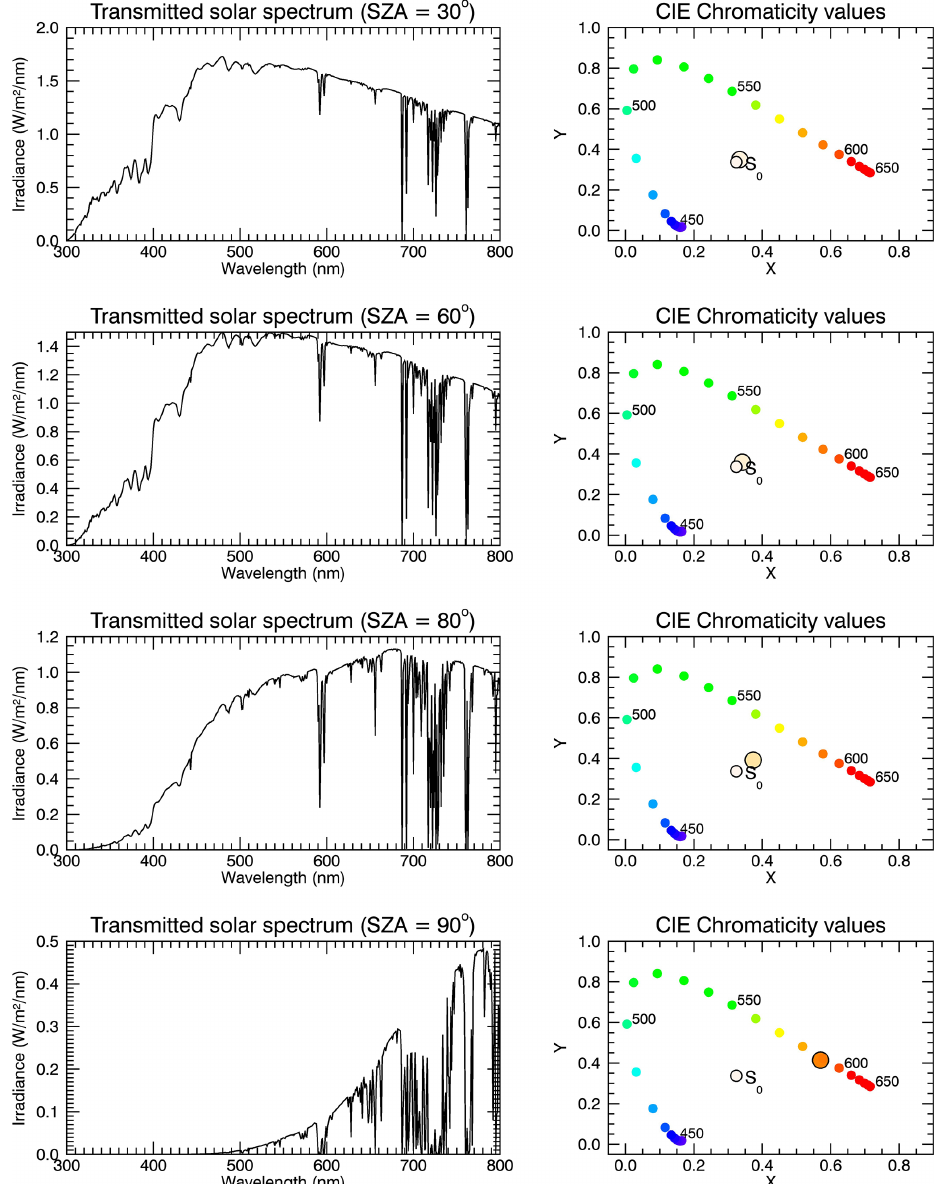
Figure 3. Results for an atmosphere without aerosols. The plots in the left column show the solar transmission spectra simulated for solar zenith angles of 30, 60, 80 and 90 ◦ , respectively (top to bottom), while the diagrams in the right column show the corresponding CIE chromaticity plots. The transmission spectra are calculated for an observer at the Earth’s surface (0ma.s.l.) looking directly into the